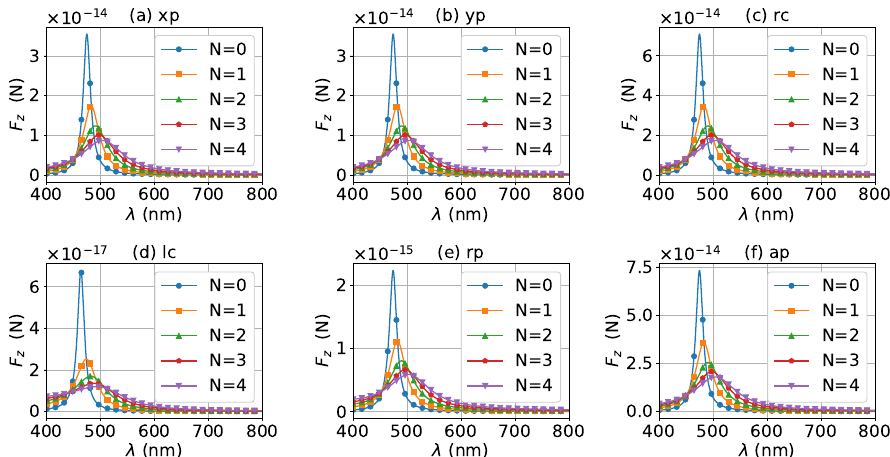
Figure 17. The same as in Figure 15, but with α 0 = 80 ◦